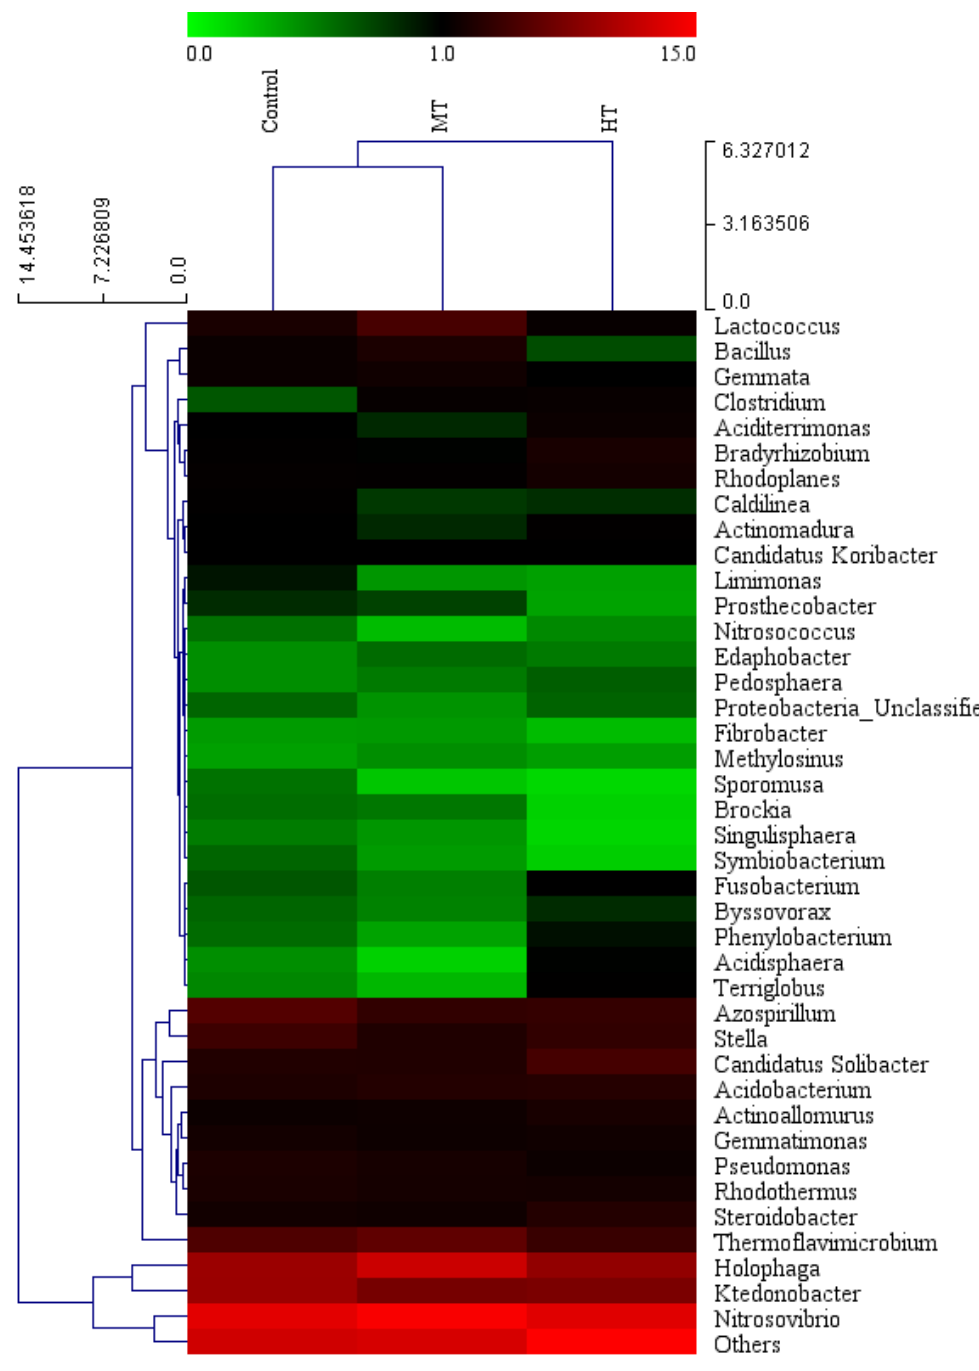
Figure A1. Hierarchically clustered heat-map analysis of the bacterial communities (top 40) at the genus level. Control: conventional management model, MT = moderate thinning, and HT = heavy thinning, n = 3.